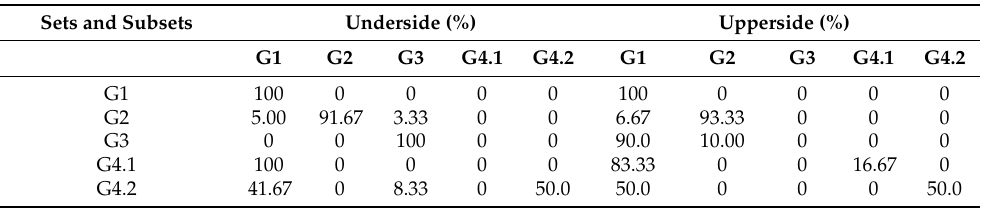
Table 4. Results of the detection of T. urticae damage on each side of the leaf using colour